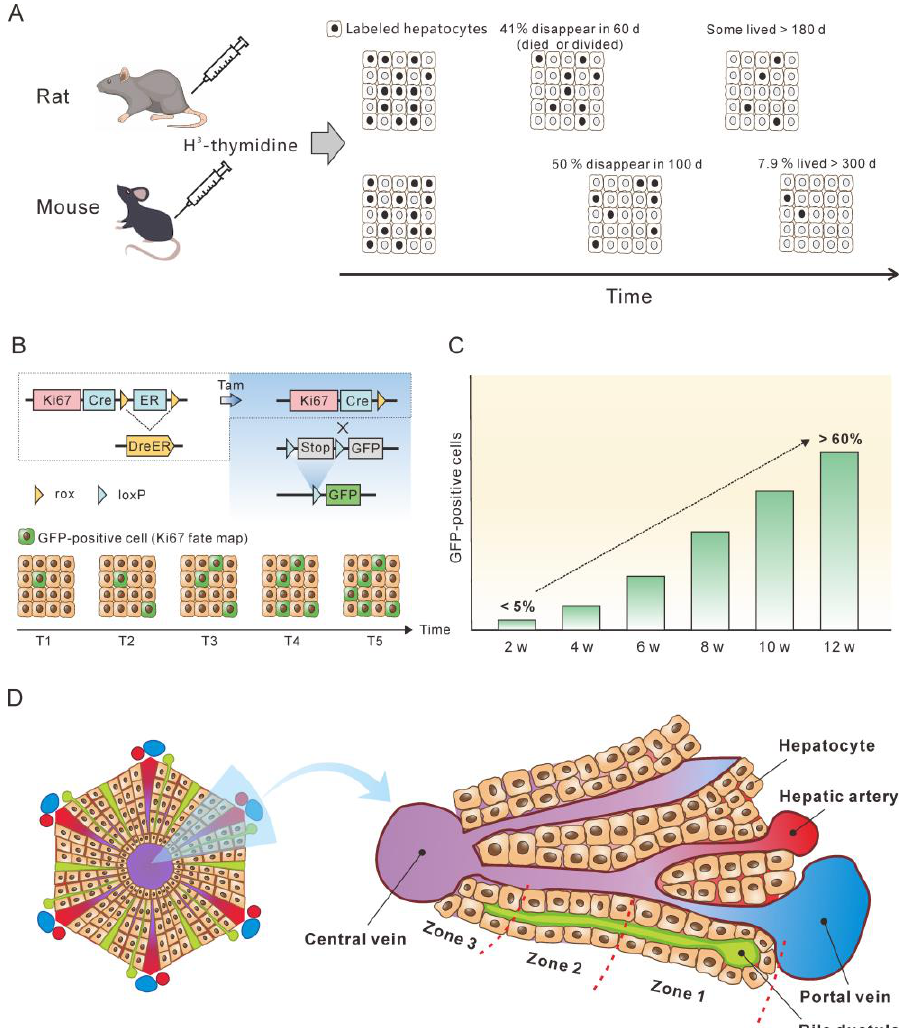
Figure 2. Monitoring the lifespan and proliferation of hepatocytes . ( A ) H 3 -thymidine was injected into rat and mouse models to label hepatocytes and monitor the changes in the labeled cells [42,43]. ( B ) Ki67 expression induced a constitutive expression of GFP which was used to monitor the fate of liver cells. ( C ) From week 2 to week 12, the number of hepatocytes with Ki67-expression-induced GFP expression increased to more than 50%, which represent newly produced hepatocytes. The figure is a modification of a figure from reference [45]. ( D ) Structure of the liver lobule. Hepatocytes in the liver lobule are organized into three zones and those in zones 2 and 1 have higher proliferation rates than those in zone 3 during